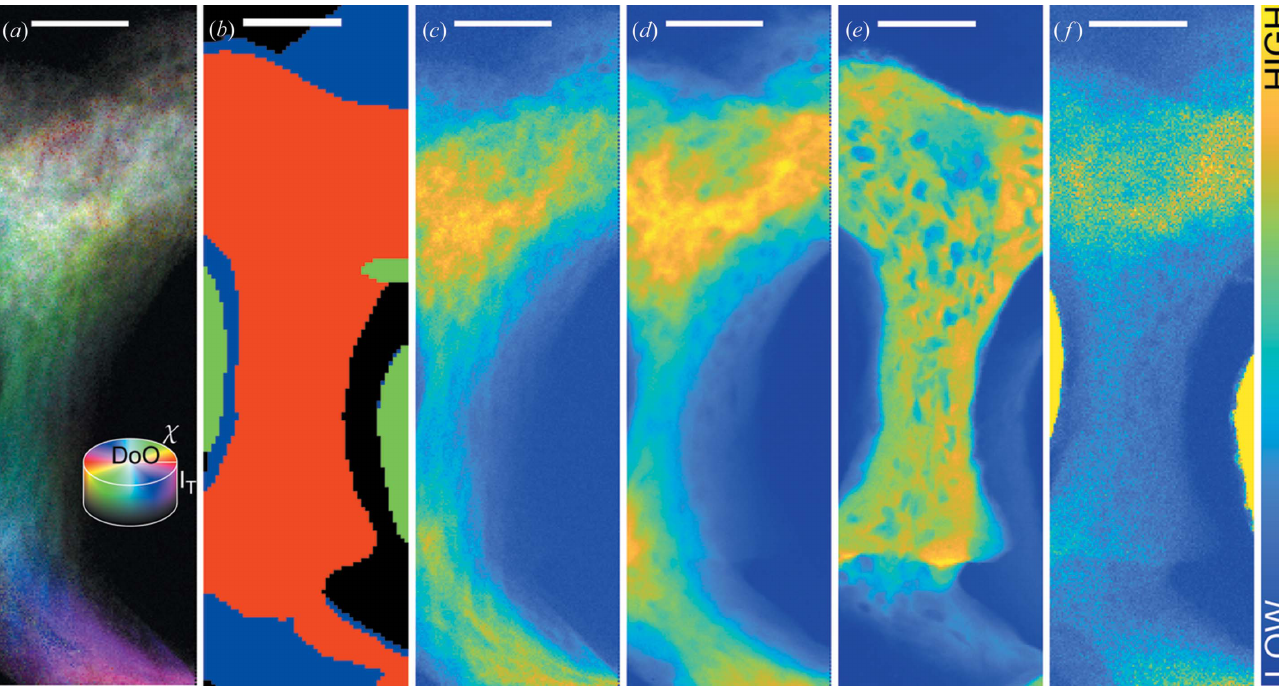
Figure 5 Analysis of the test sample consisting of a tensile load screw and surrounding bone. ( a ) Orientational distribution H(ue) S(aturation) V(alue) map of the full sample, for every pixel the process like that described in Section 2.2.2 has been carried out if sufficient HAP (002) signal was present. The hue of a point reveals the crystallite orientation, the saturation reveals the projected degree of orientation and the value reveals the total projected (002) intensity in the point. ( b )–( f ) XRFand XRD analysis. ( b ) Segmentation sketch based on XRF signals. The Ca signal in red shows areas where bone is close to the sample surface, the Ni signal in green shows the location of the implant tension spring, and the Sr signal in blue shows areas where there is bone further from the sample surface. ( c ) HAP (002) integrated intensity. ( d ) HAP multiplet integrated intensity. ( e ) XRF Ca signal. ( f ) XRF Sr signal. Scale bars are 50 m m. The outermost 3 m m in ( a )–( f ) have been removed on both the left and the right, due to edge effects; thus ( a ), ( c ) and ( d ) contain 104 (cid:3) 350